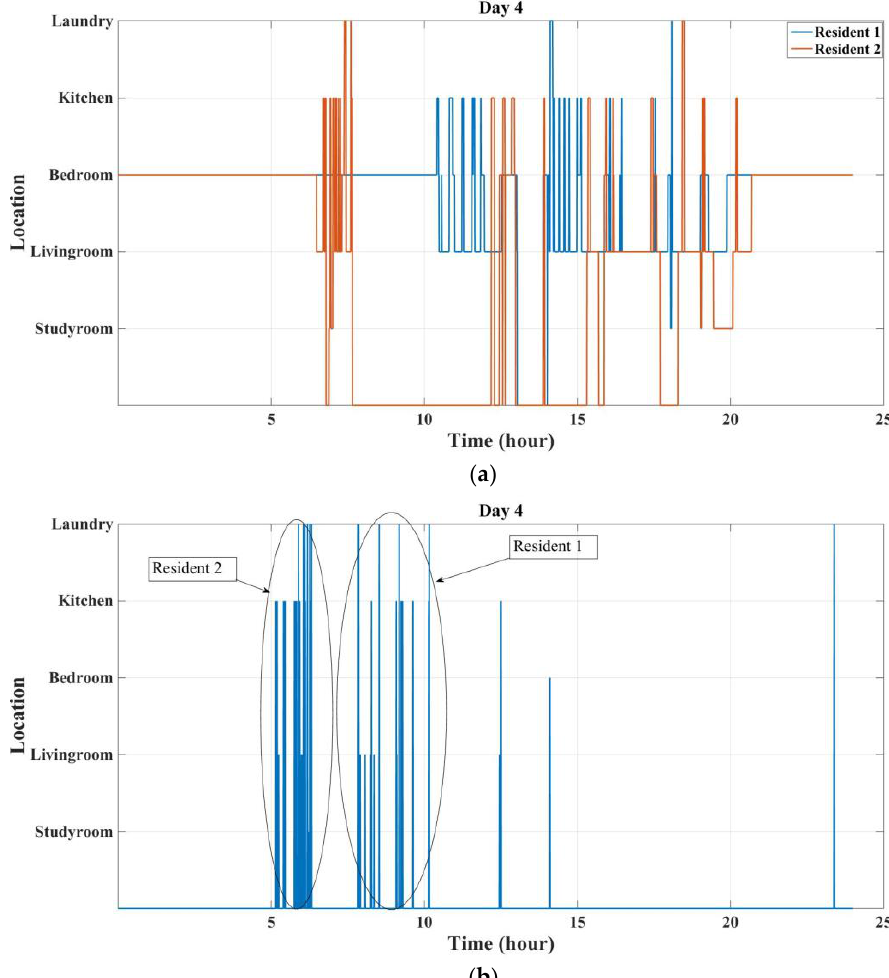
Figure 13. Localization and activity labelling results for the fourth day: ( a ) Residents localization results; ( b ) Non-labelled sensor events.